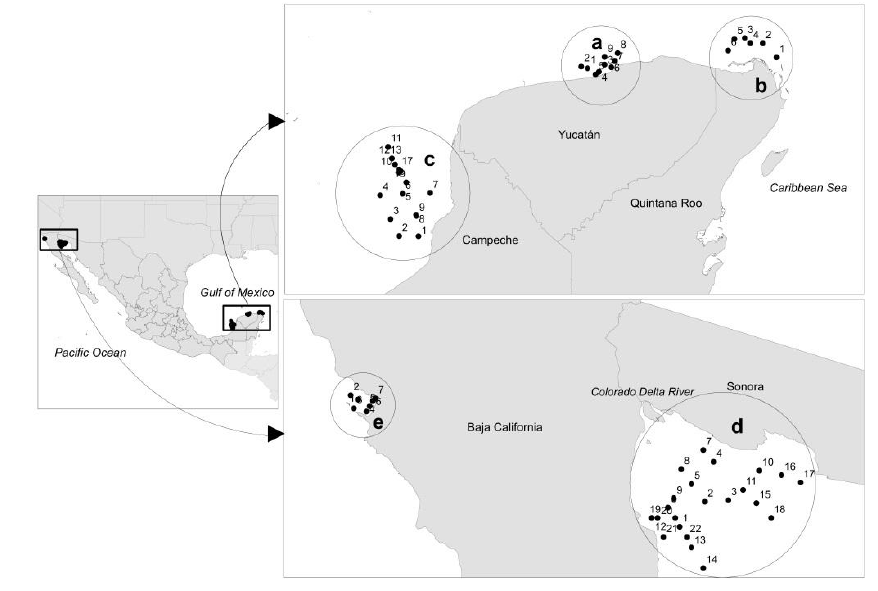
Figure 1. Sampling stations. ( a ) Dzilam de Bravo (Yucatan); ( b ) Holbox (Quintana Roo); ( c ) Campeche Bay (Campeche); ( d ) Upper Gulf of California (Baja California and Sonora) and ( e ) Todos Santos Bay (Baja